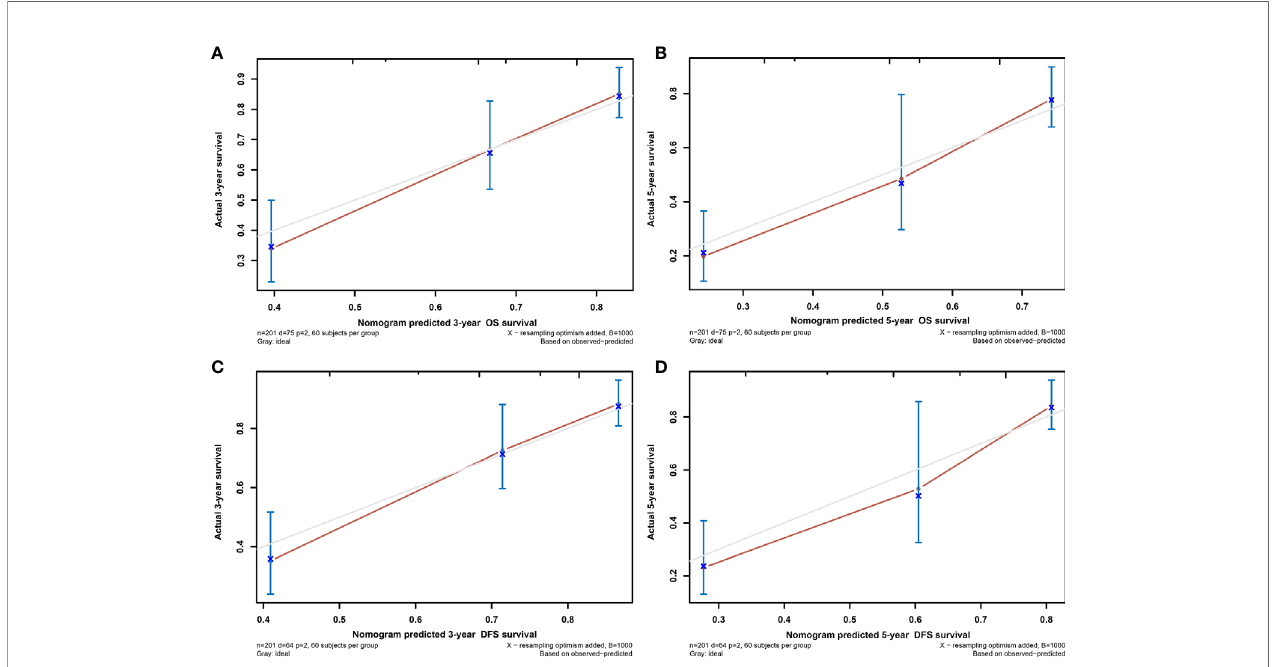
FIGURE 5 | The calibration curves of the nomogram predicting 3-year OS (A) , 5-year OS (C) , 3-year DFS (B) , and 5-year DFS (D) . OS, overall survival; DFS, disease-free survival.